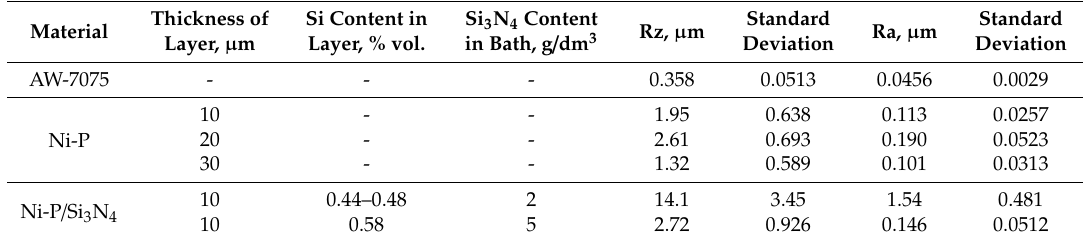
Table 5. Roughness parameters of AW-7075, Ni-P, and Ni-P / Si 3 N 4 layers.